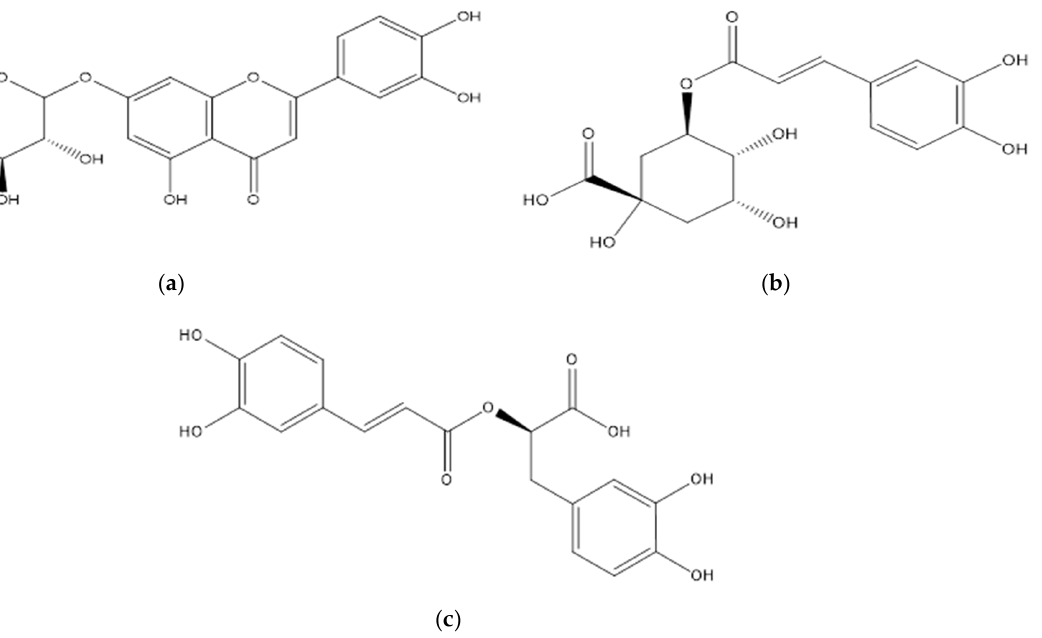
Figure 4. Absorption spectrum of rosmarinic acid isolated from T. vulgare extracts.